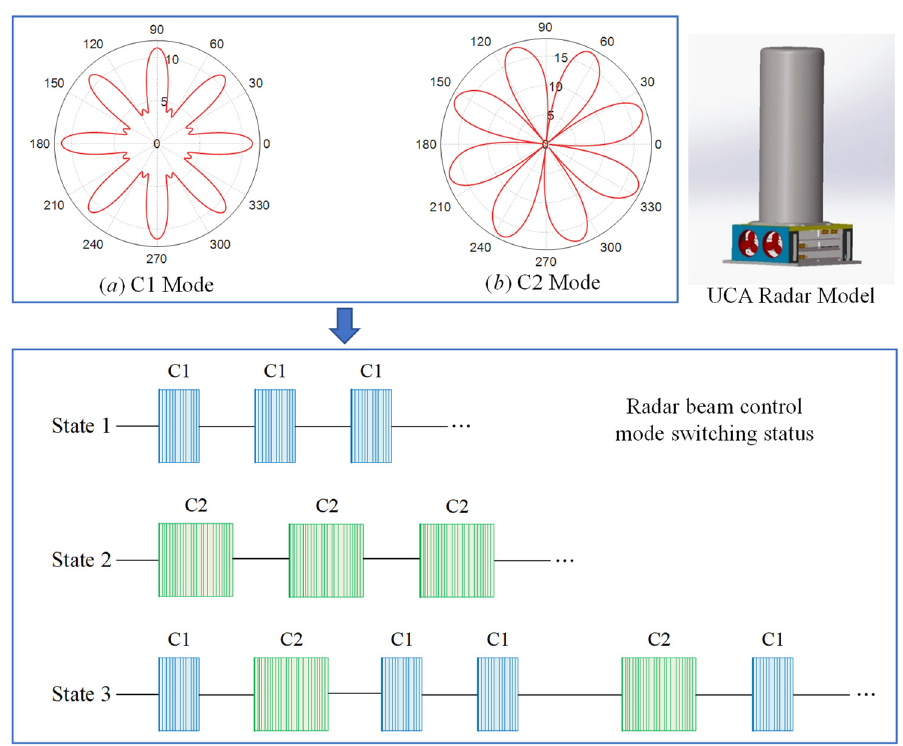
Figure 1. Switching states of two-beam control modes and corresponding beam pointing simulation pattern.